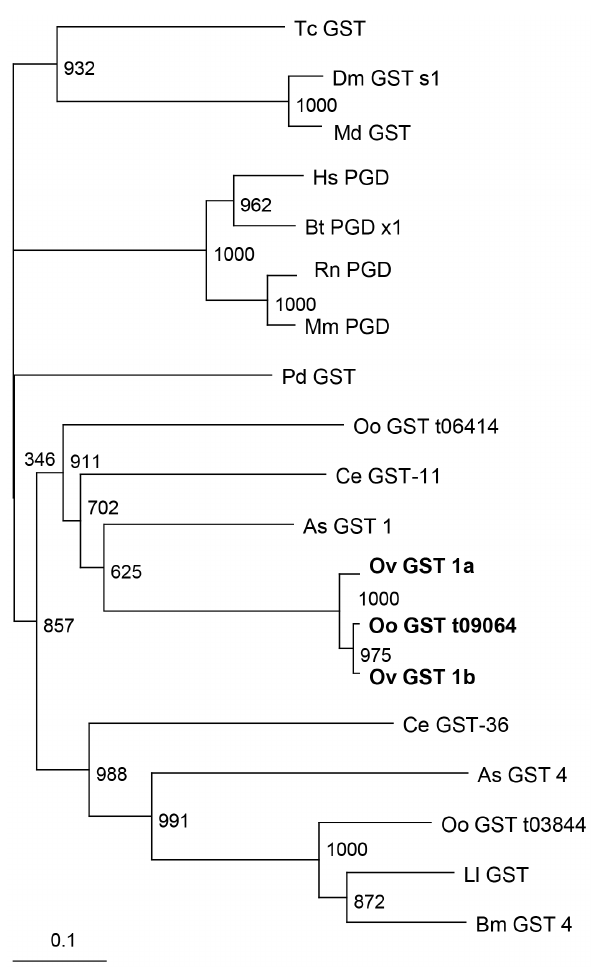
Figure 1. Phylogenetic neighbour-joining tree showing the relationship of the sigma-class GSTs of Onchocercaochengi to similar enzymes of nematodes, mammals and insects. Numbers shown alongside branches are bootstrap values of 1,000 replications. The key for protein sequence accession numbers and organisms displayed in the tree is as follows: Nematodes: